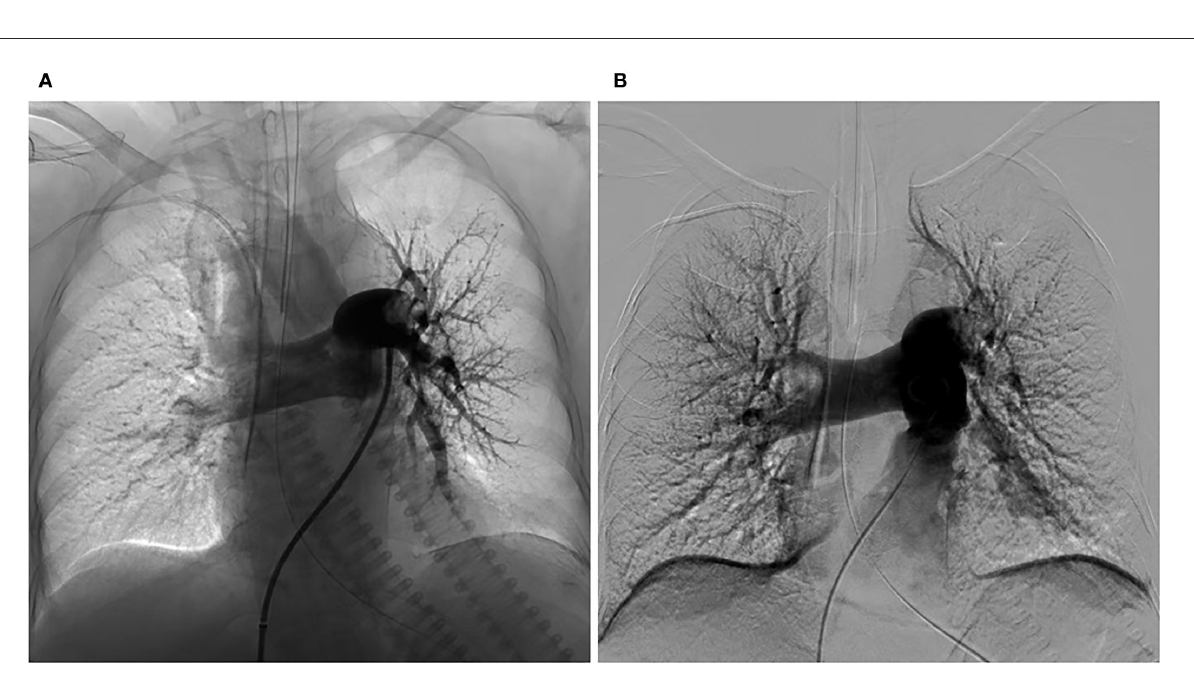
pulselessness, or persistent profound bradycardia, resulting in mortality rates as high as 25 to 65% in the absence of an early diagnosis and timely intervention (2,